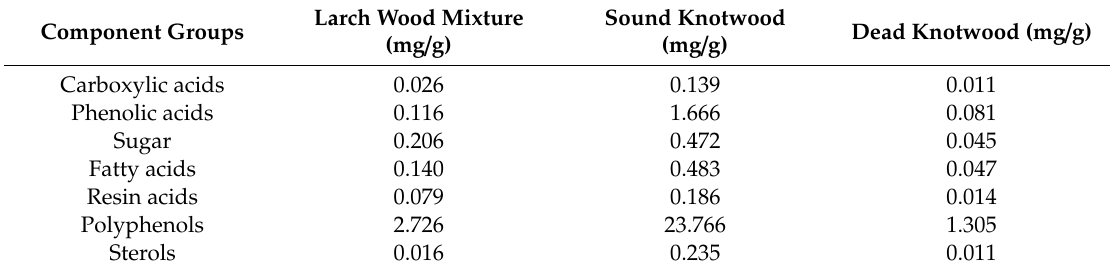
Table 1. Main component groups in acetone / water extracts of di ff erent larch wood materials by GC-MS. Component